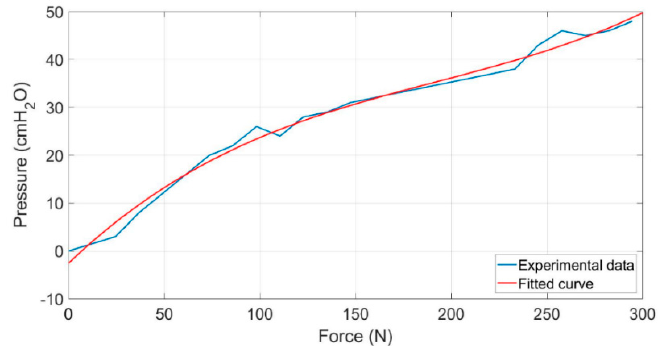
Figure 20. Relation between force compressing AmbuBag and its output pressure.